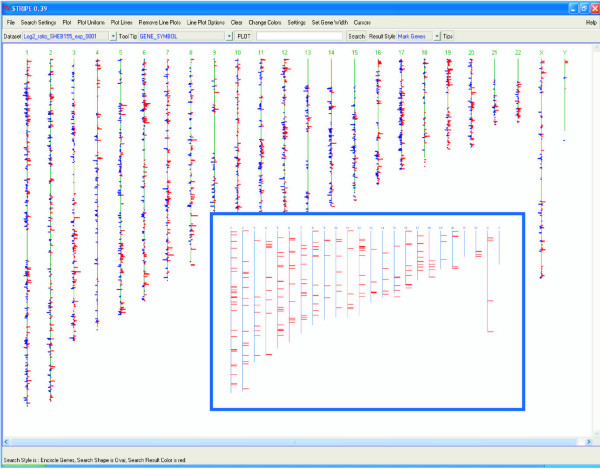
Plotting experimental data from a gene expression profiling study on renal cell carcinoma plotted with STRIPE. Upregulated genes are colored red and down regulated genes shown in blue. The inset depicts a genome-based representation of the genes identified as predictors for survival in conventional renal cell carcinoma. The numerical values of the data are scaled along the horizontal axis.